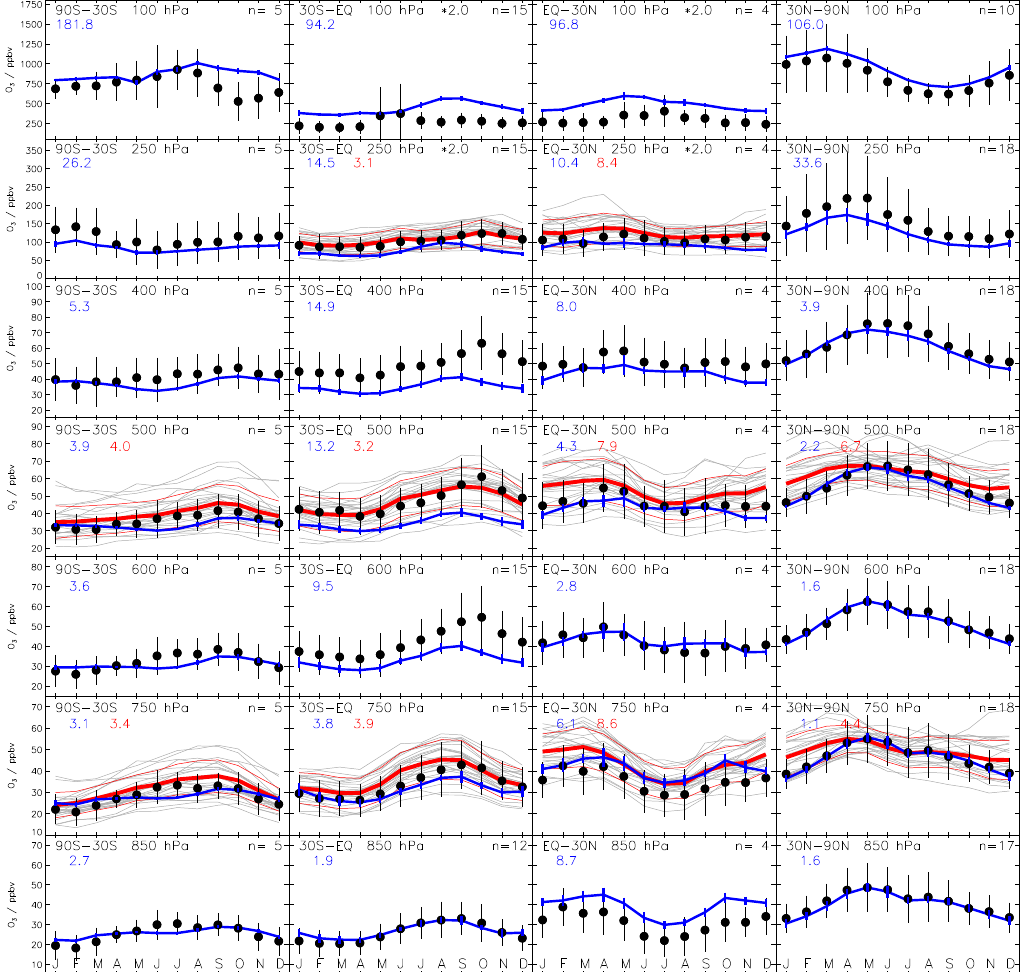
Fig. 26. Comparison of the annual cycle of O 3 observations (black) with UKCA StdTrop (blue), the ACCENT ensemble of models (grey) and the ACCENT multi-model ensemble mean (red). Observations are taken from Logan et al. (1999), Thompson et al. (2003a) and Thompson et al. (2003b). The modelled and observed O 3 concentrations at 100 and 250 hPa in the latitude bands 30 ◦ S–EQ and EQ–30 ◦ N have been multiplied by a factor of 2. The root mean square error in ppbv between UKCA StdTrop and the observations is included in blue and the root mean square error in ppbv between the ACCENT multi-model mean and the observations is included in red.